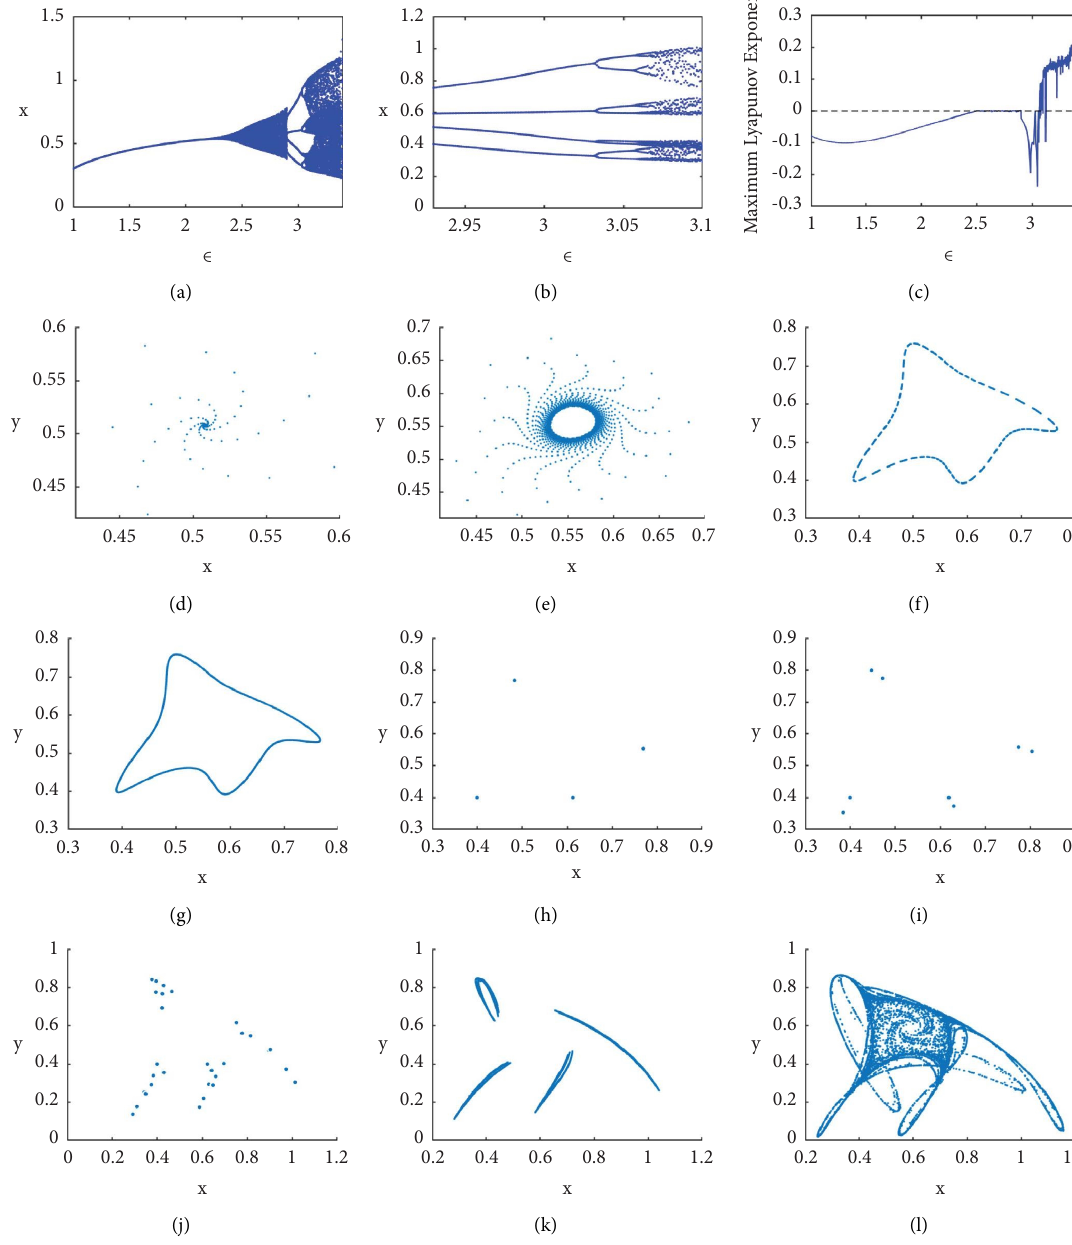
Figure 9: (a) Bifurcation diagram of model (4) in ( ε , x ) plane. (b) Local amplifcation for ε ∈ ( 2 . 93 , 3 . 1 ) corresponding to (a). (c) Maximum Lyapunov exponents corresponding to (a). Phase-plane diagrams for various values of ε corresponding to Figure 8(a): (d) ε � 1 . 9, (e) ε � 2 . 5, (f) ε � 2 . 875, (g) ε � 2 . 88, (h) ε � 2 . 976, (i) ε � 3 . 048, (j) ε � 3 . 101, (k) ε � 3 . 131, and (l) ε � 3 .